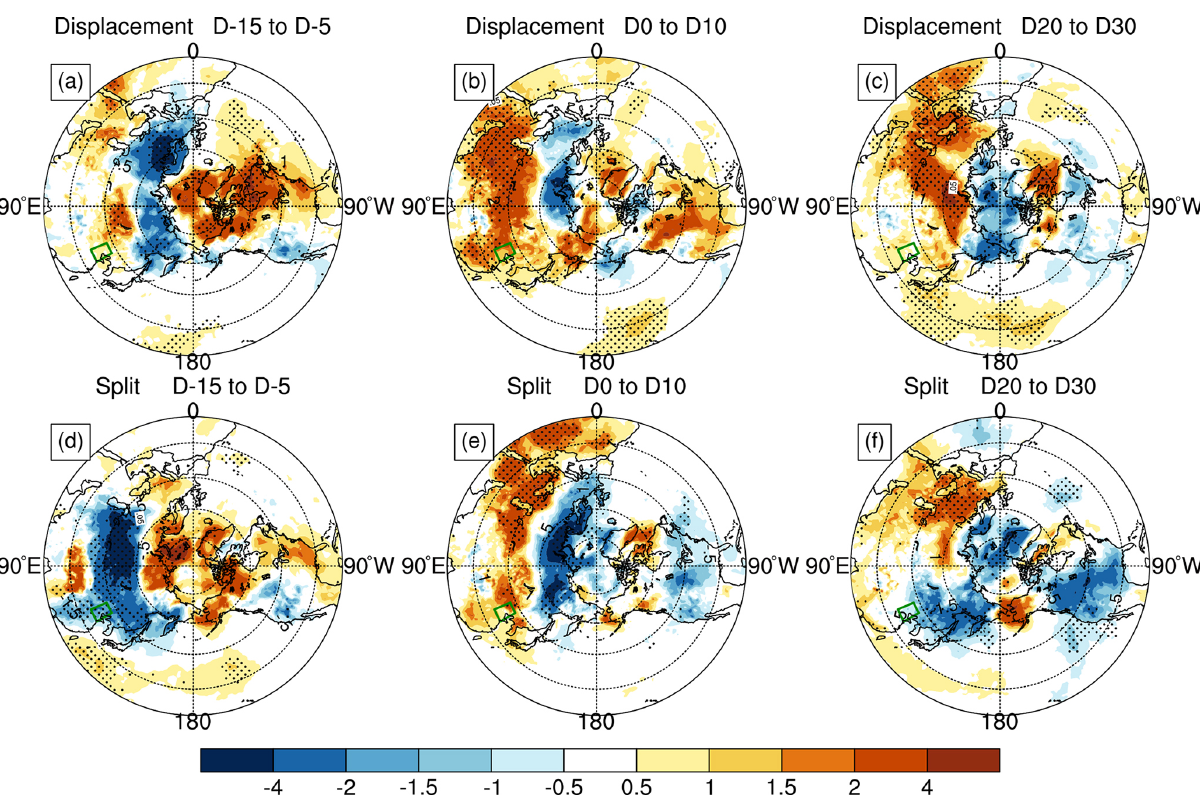
Figure 4. Composite 2m temperature (t2m) anomalies in the Northern Hemisphere during three periods of the SSW for vortex displacement events (a–c) and vortex split events (d–f) . (a, d) Day − 15 to day − 5 in the pre-SSW period. (b, e) Day 0 to day 10 in the SSW onset period and afterwards. (c, f) Day 20 to day 30 in the SSW decaying period. The dotted regions mark the composite t2m anomalies at the 95% confidence level based on the two-sided Student’s t test. The green box marks the focused BTH